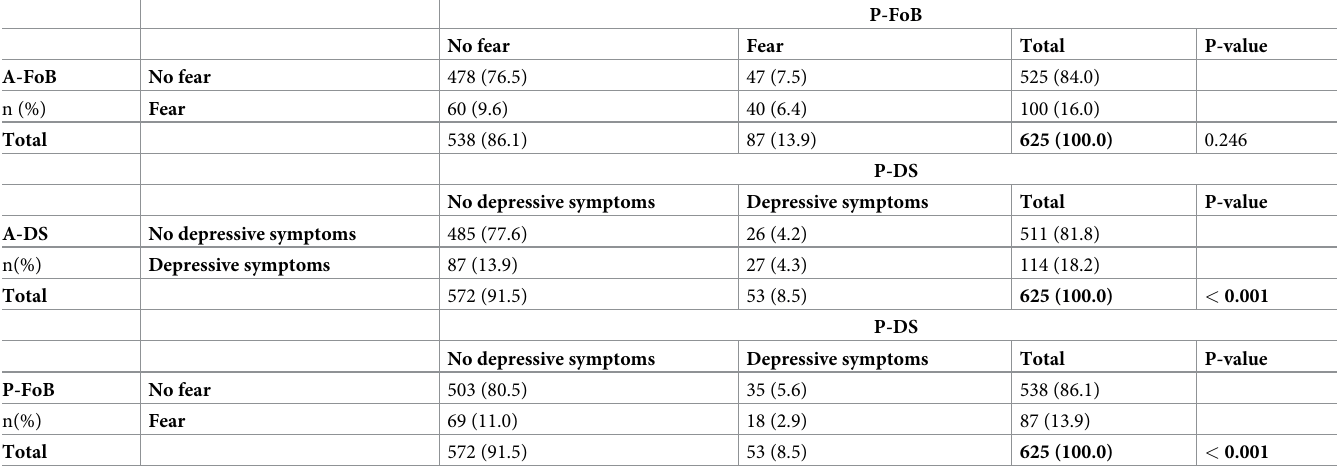
Table 3. Patterns of fear of childbirth and depressive symptoms during pregnancy and after